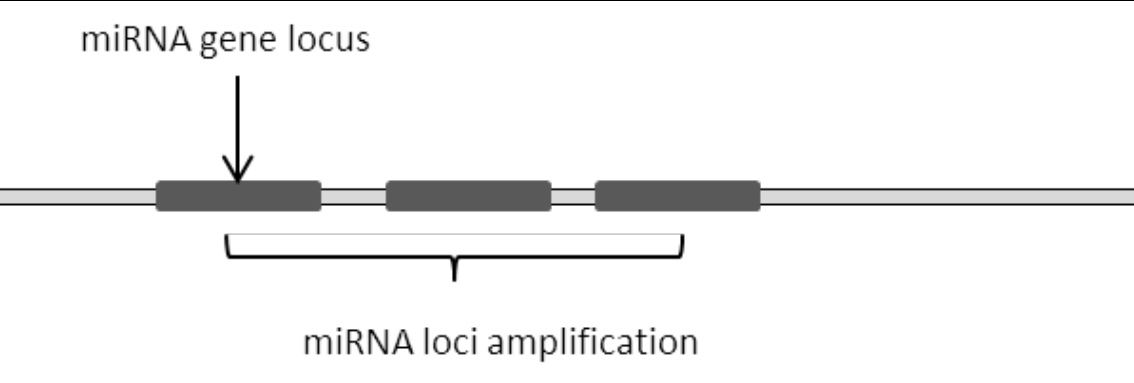
Figure 1. miRNA loci amplification resulted in repeating miRNA sequences thus increasing basal expression of